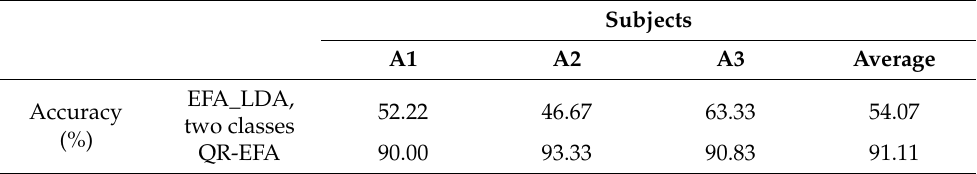
Table 2. EEG analysis accuracy for C3D3a_4C using QR-EFA method.